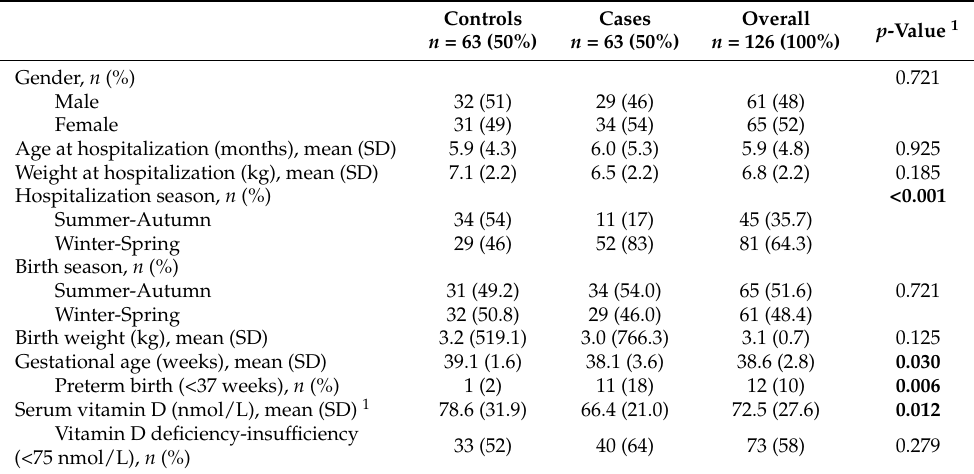
Table 1. Characteristics of the study sample by